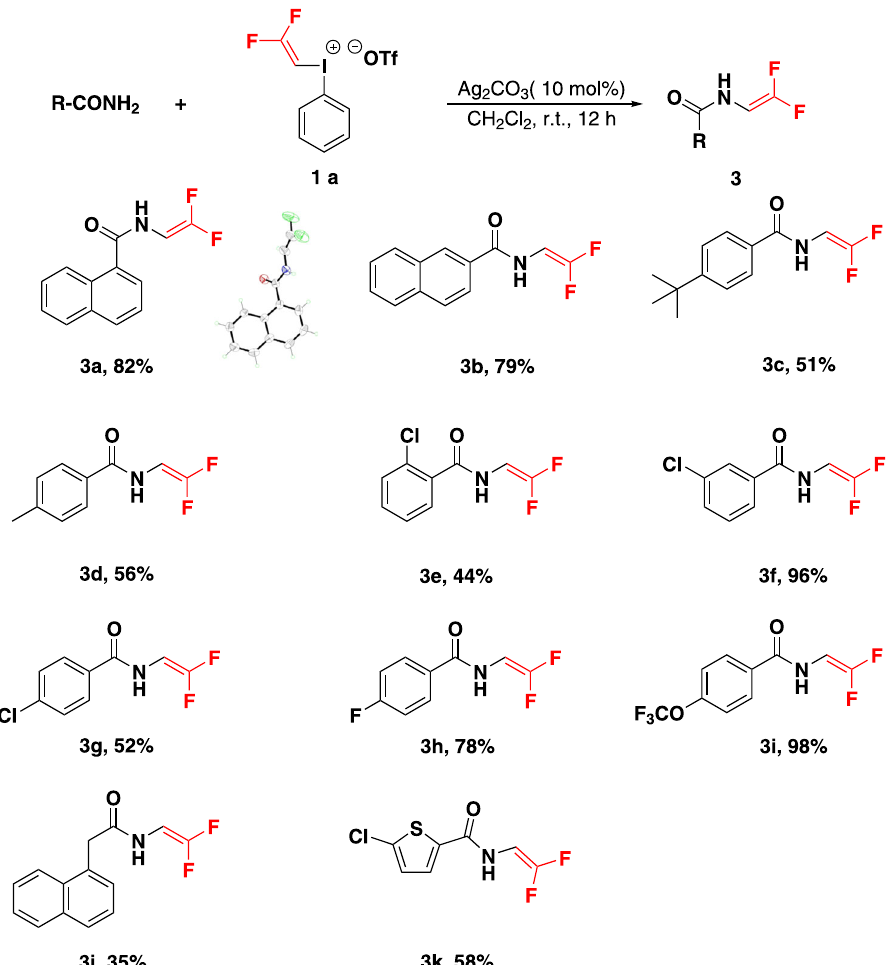
Fig. 5 Electrophilic gem-di fl uorovinylation of amide. Reaction conditions: amide (0.8 mmol), 1a (0.2 mmol), Ag 2 CO 3 (0.02 mmol) in CH 2 Cl 2 (2.0 ml) at room temperature for 12 h. Yields shown are of isolated products. CCDC No.: